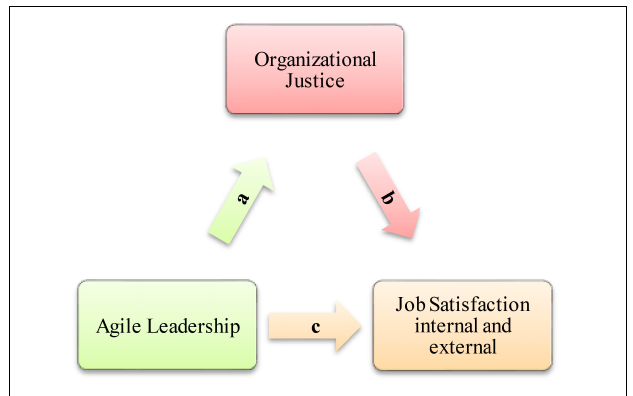
FIGURE 1 | The conceptual framework for the